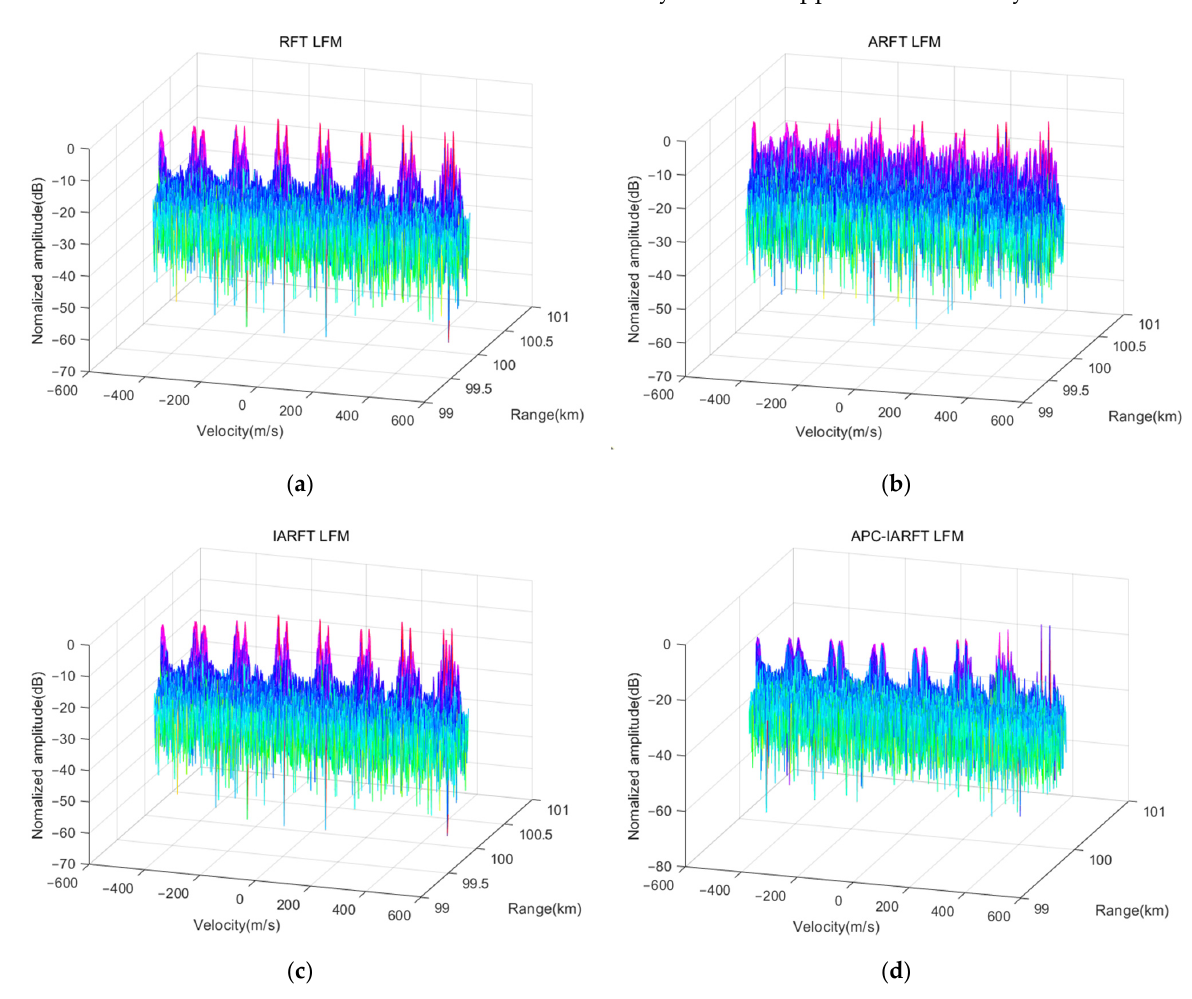
Figure 11. Stereogram output of four methods in Scenario 3: ( a ) Output of RFT; ( b ) Output of ARFT; ( c ) Output of IARFT; ( d ) Output of APC-IARFT.